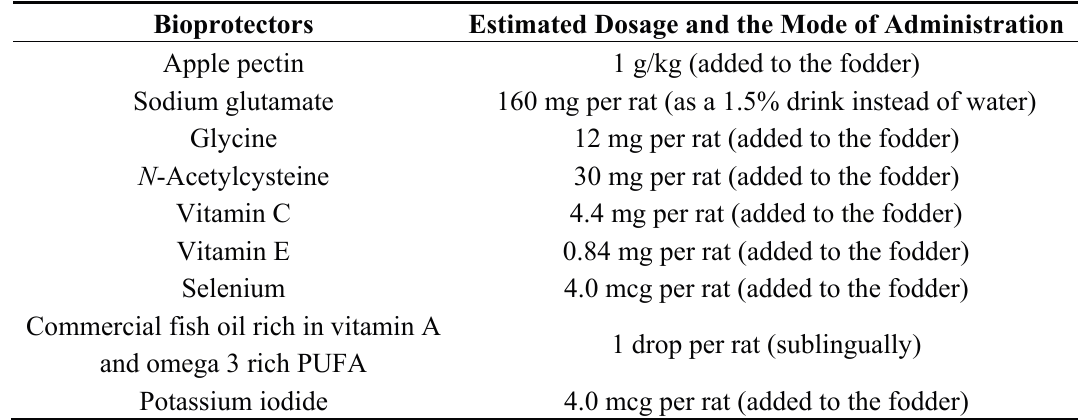
Table 8. Doses and the mode of administration of the bioprotectors tested in our